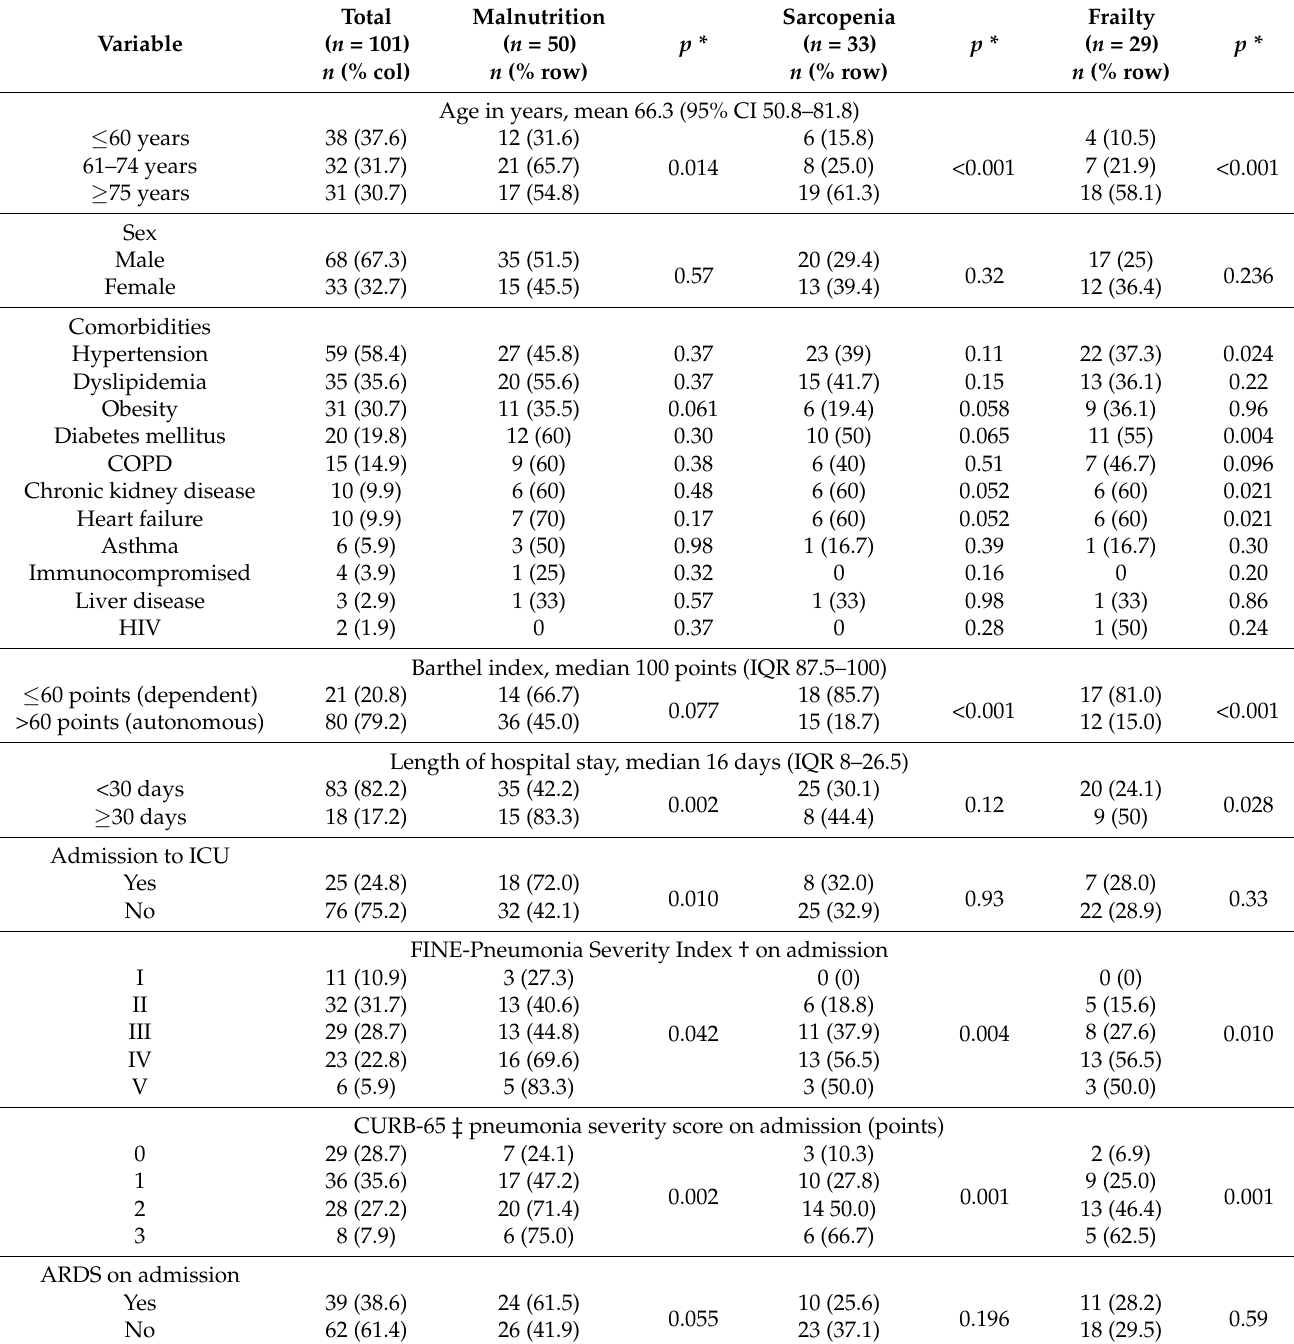
Table 1. Patient characteristics according to prevalence of malnutrition, sarcopenia, and